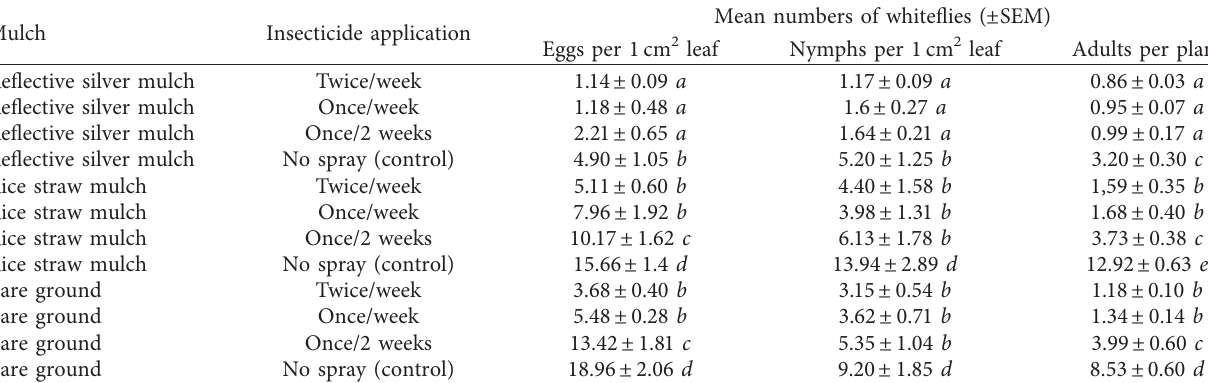
Table 4: Influence of insecticide and mulch treatments on the average numbers of whitefly eggs, nymphs, and adults across cultivars, 2019. Mulch Reflective silver